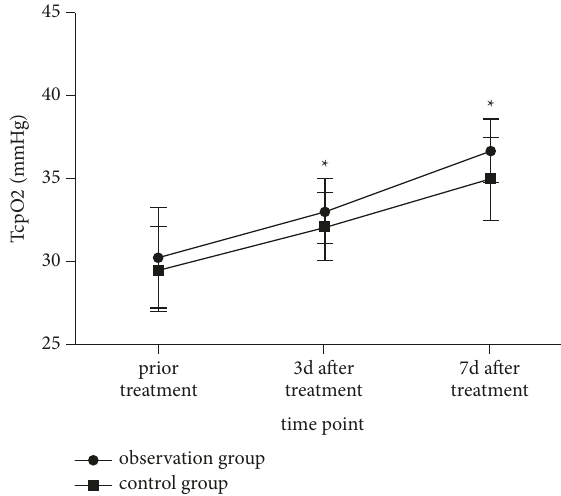
Figure 12: Comparison of IL-6 between the two groups before and after